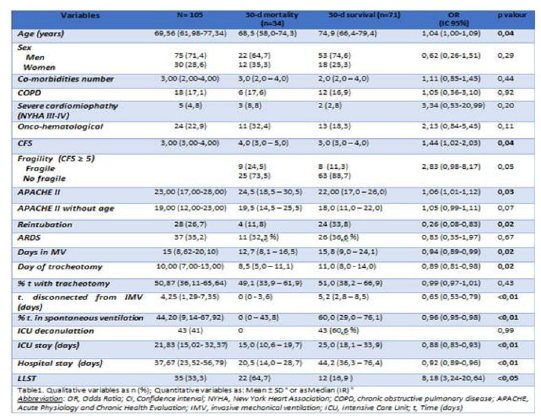
Table 1 (abstract 000912). See text for description